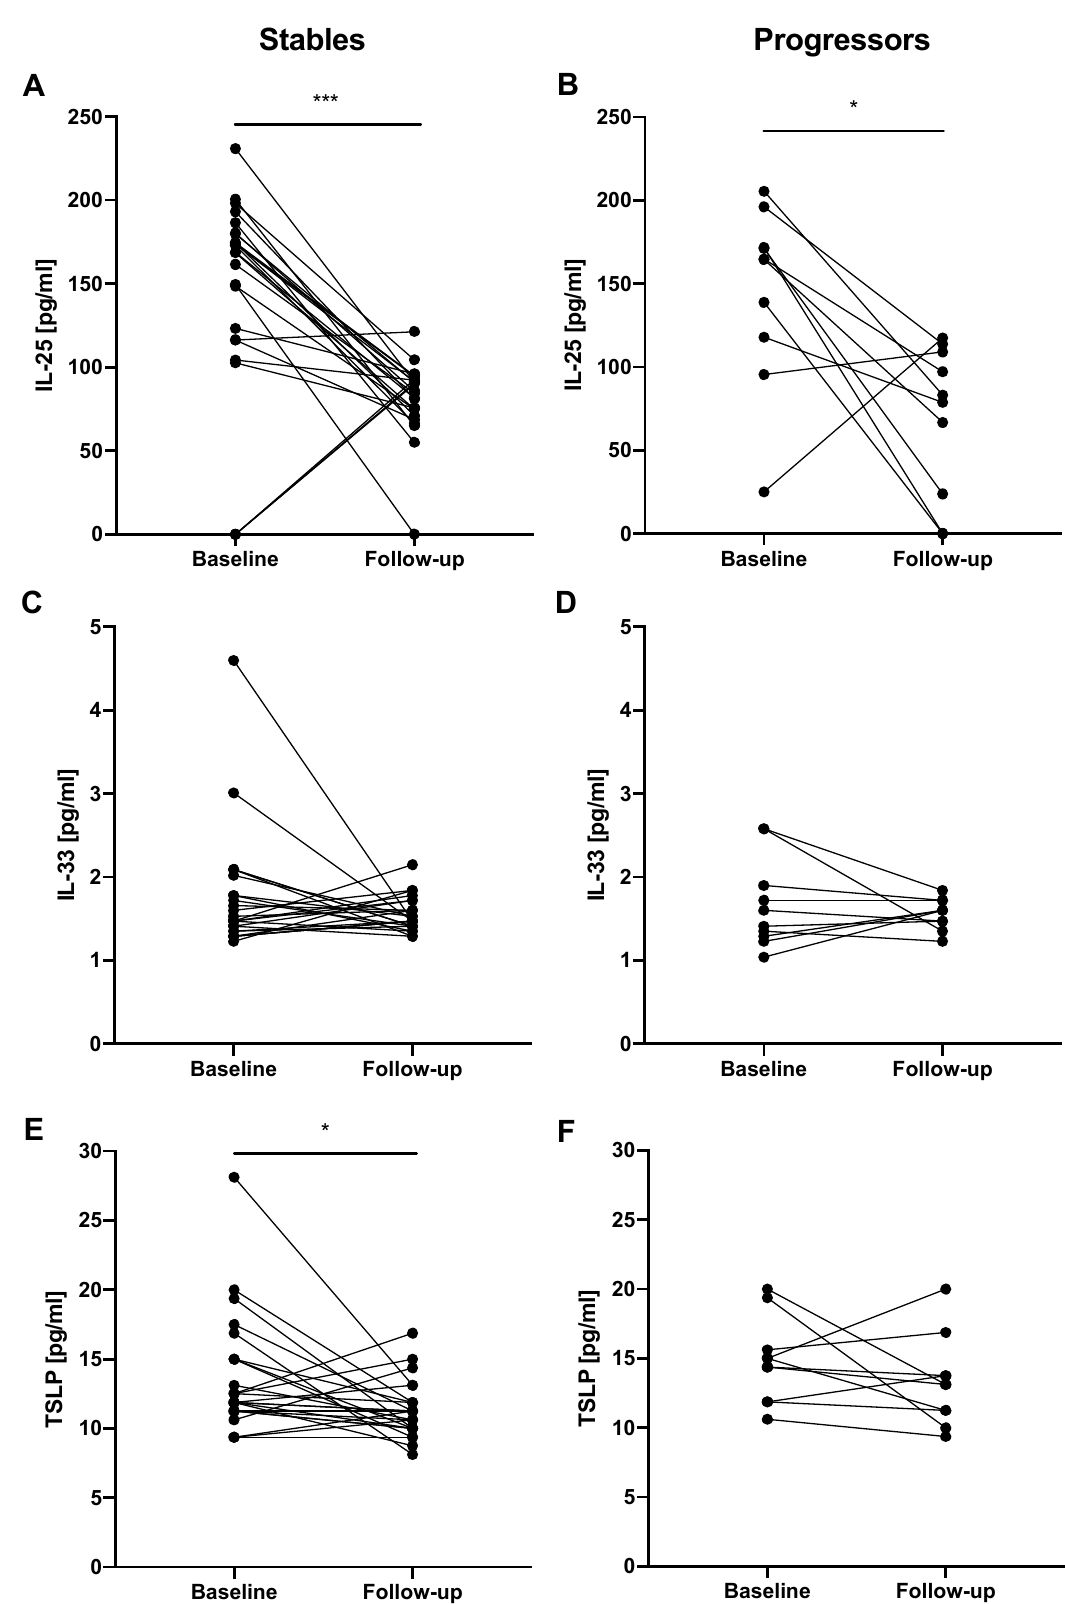
Figure 7. Changes in the epithelial alarmin levels in the EBC of patients with IPF before and after 12 months of antifibrotic therapy according to the functional decline (stables—FVC % of predicted decline/year ≤ 5%; progressors—FVC % of predicted decline/year > 5%). Notes: Panels showing: ( A ) change in IL-25 EBC levels in stable IPF patients; ( B ) change in IL-25 EBC levels in progressor IPF